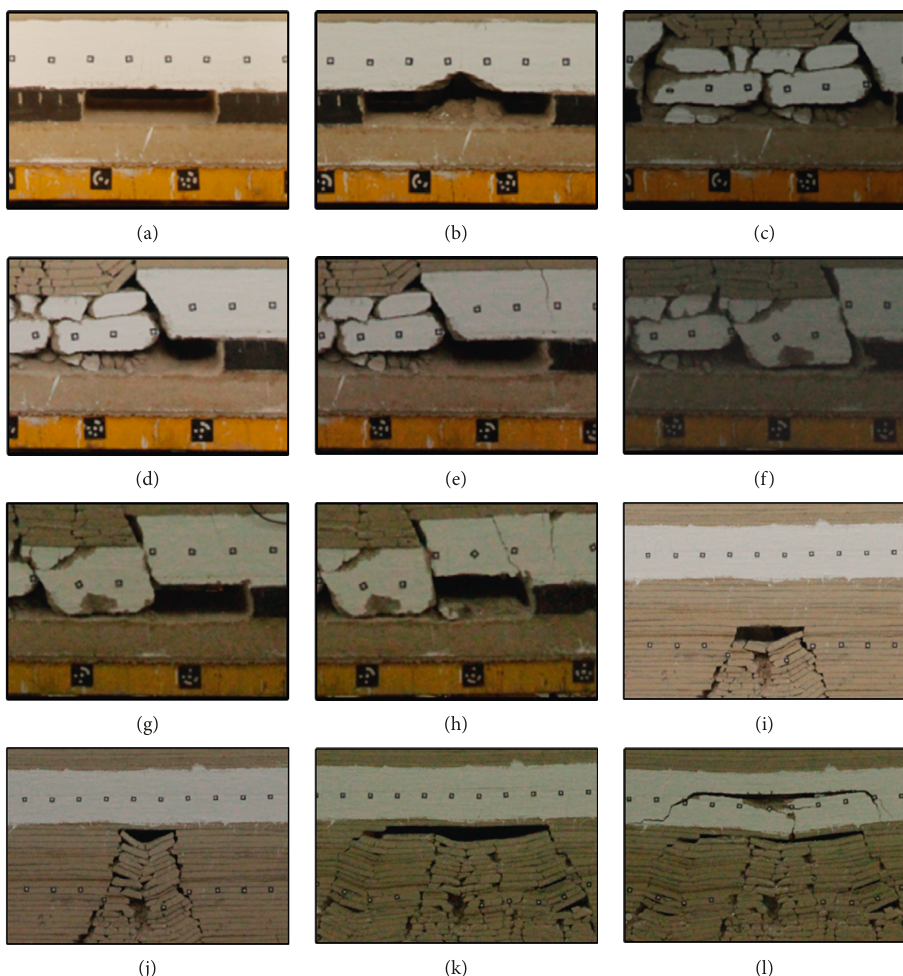
Figure 5: Roof activation characteristics. (a) Roof bending. (b) Roof fracture. (c) Roof caving. (d) Cantilever construction. (e) Cantilever construction fracture. (f) Cantilever construction caving. (g) Cantilever construction. (h) Cantilever construction fracture. (i) Upper roof condition. (j) Suspended upper roof. (k) Upper roof fracture. (l) Upper roof fracture and